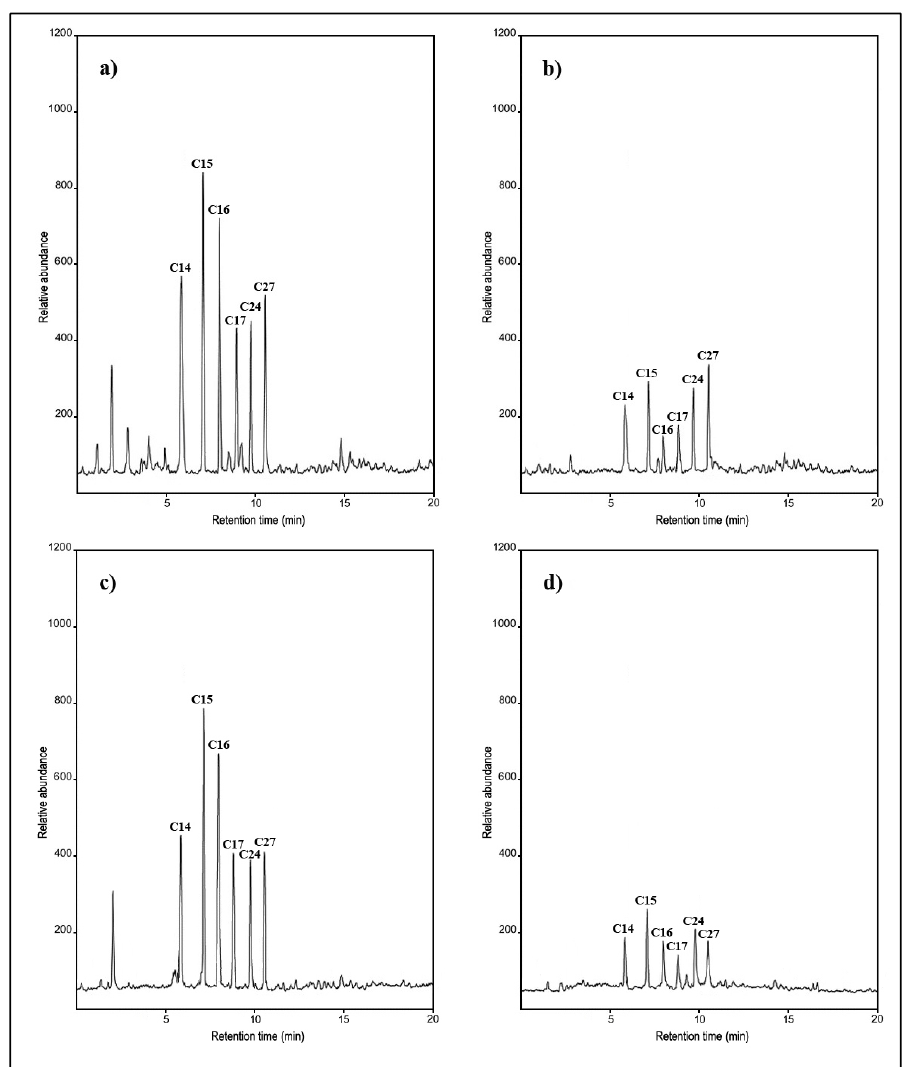
Figure 2. Gas chromatography-mass spectrometry (GC-MS) analysis of crude oil samples before and after biodegradation. ( a ) The crude oil control; ( b ) biodegradation sample of A. flavus AF15 and AgNPs 0.05 g; ( c ) degradation sample of AgNPs 0.2 g and ( d ) degradation sample of A. flavus AF15, T. harzianum TH07 and AgNPs 0.05 g, all treatments after 7